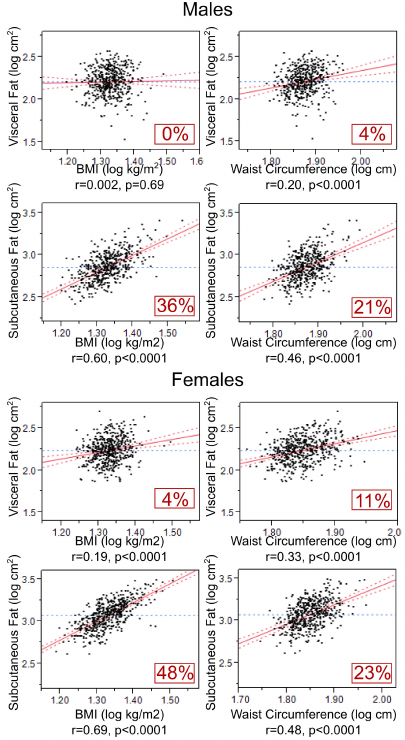
Figure 2. BMI and waist circumference as predictors of VF- and SF-specific quantities (VF and SF adjusted for each other). Multivariate linear regression models examining the relationships of BMI and waist circumference with each VF and SF (while adjusting for each other) are shown in adolescent males and females. All relationships were also adjusted for potentially confounding effects of age and height when